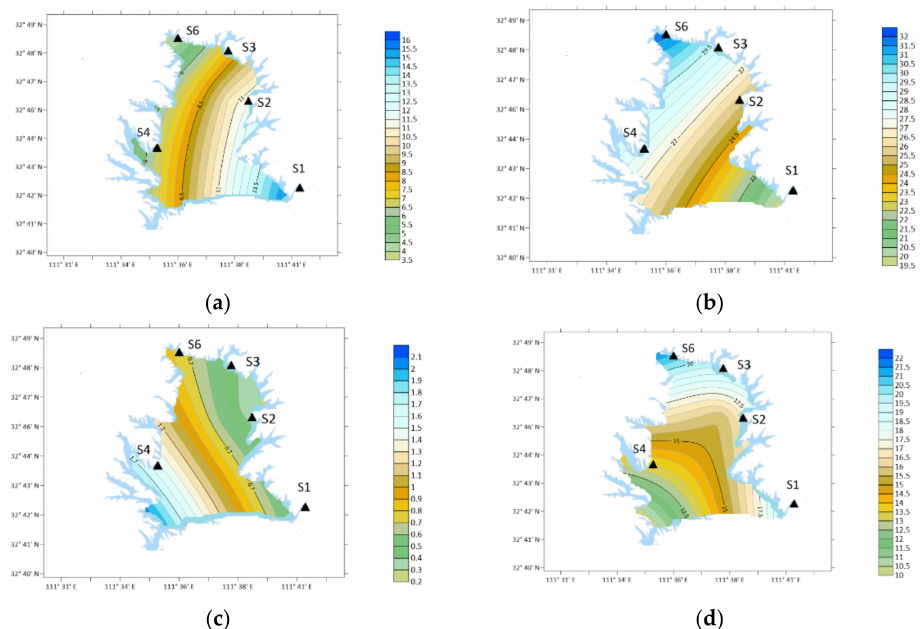
Figure 14. Spatial variation of concentration of benzamine. ( a ) Winter; ( b ) spring; ( c ) summer; ( d ) autumn.